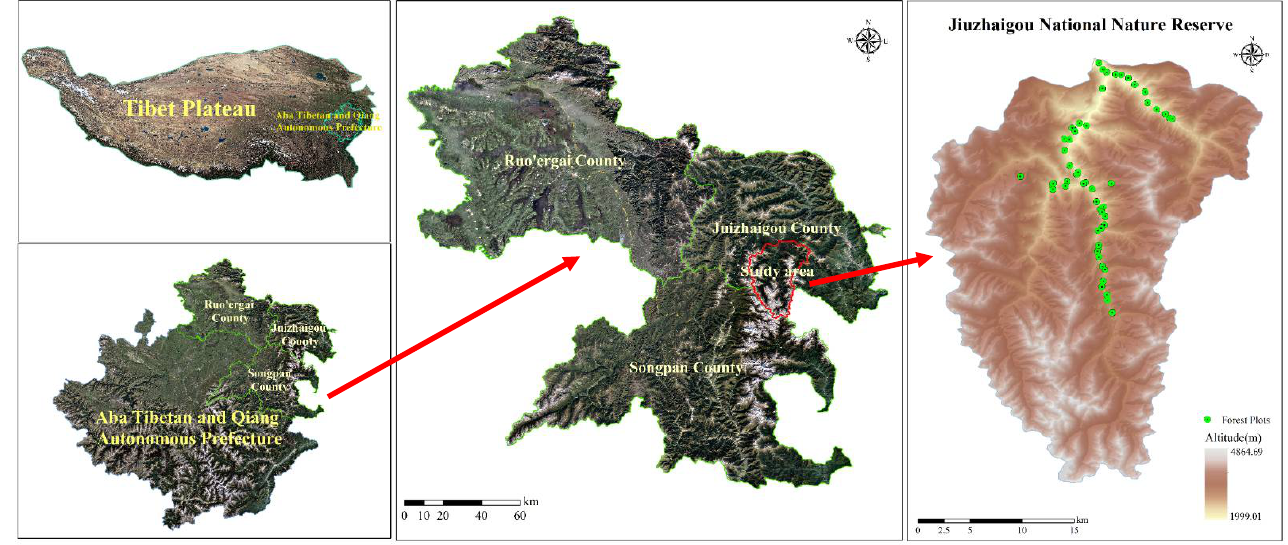
Figure 1. Location of the study area (Jiuzhaigou National Nature Reserve) and field data.